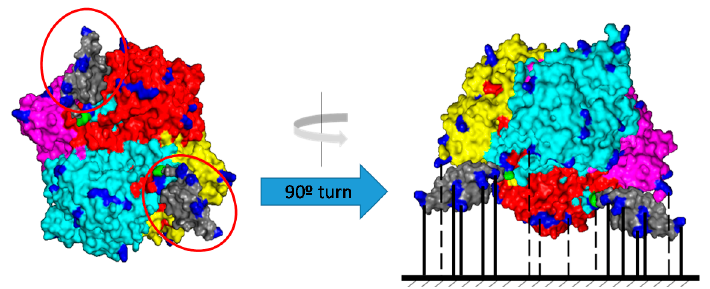
Figure 1. 3D-structure of Bordetella pertussis catalase fused with the Zbasic domain (KatA) and its immobilization via multipoint covalent attachment to glyoxyl-agarose supports. Amino-terminal end residues (Green). Lysine residues (Blue). Zbasic domains